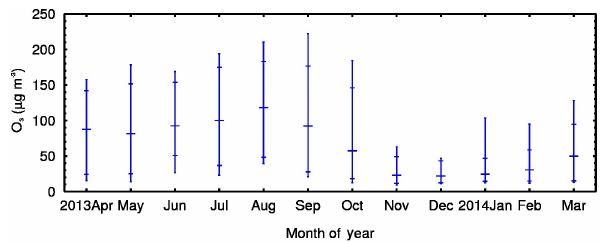
Figure 4. Monthly minimum, 5th percentile, median, 95th per- centile, and maximum of near-surface O 3 concentrations in the af- ternoon averaged over 13 observational sites in Xi’an from April 2013 to March